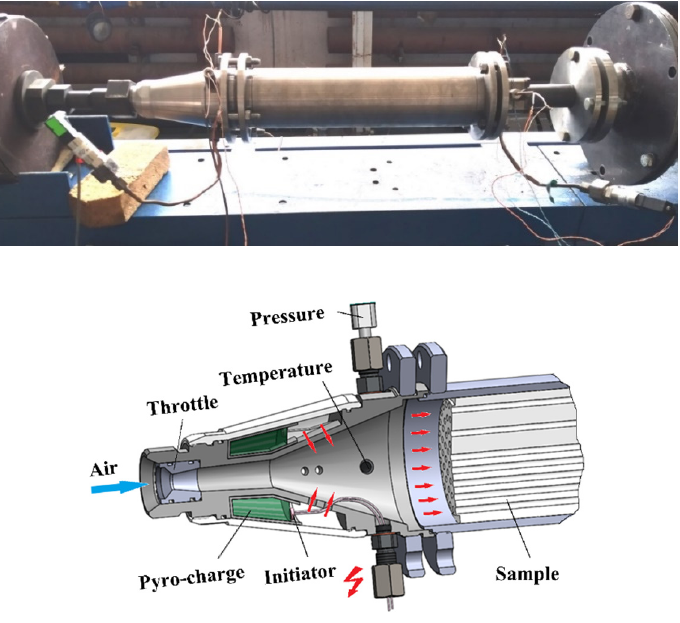
Figure 5. Gas generator with pyro-charge-assisted